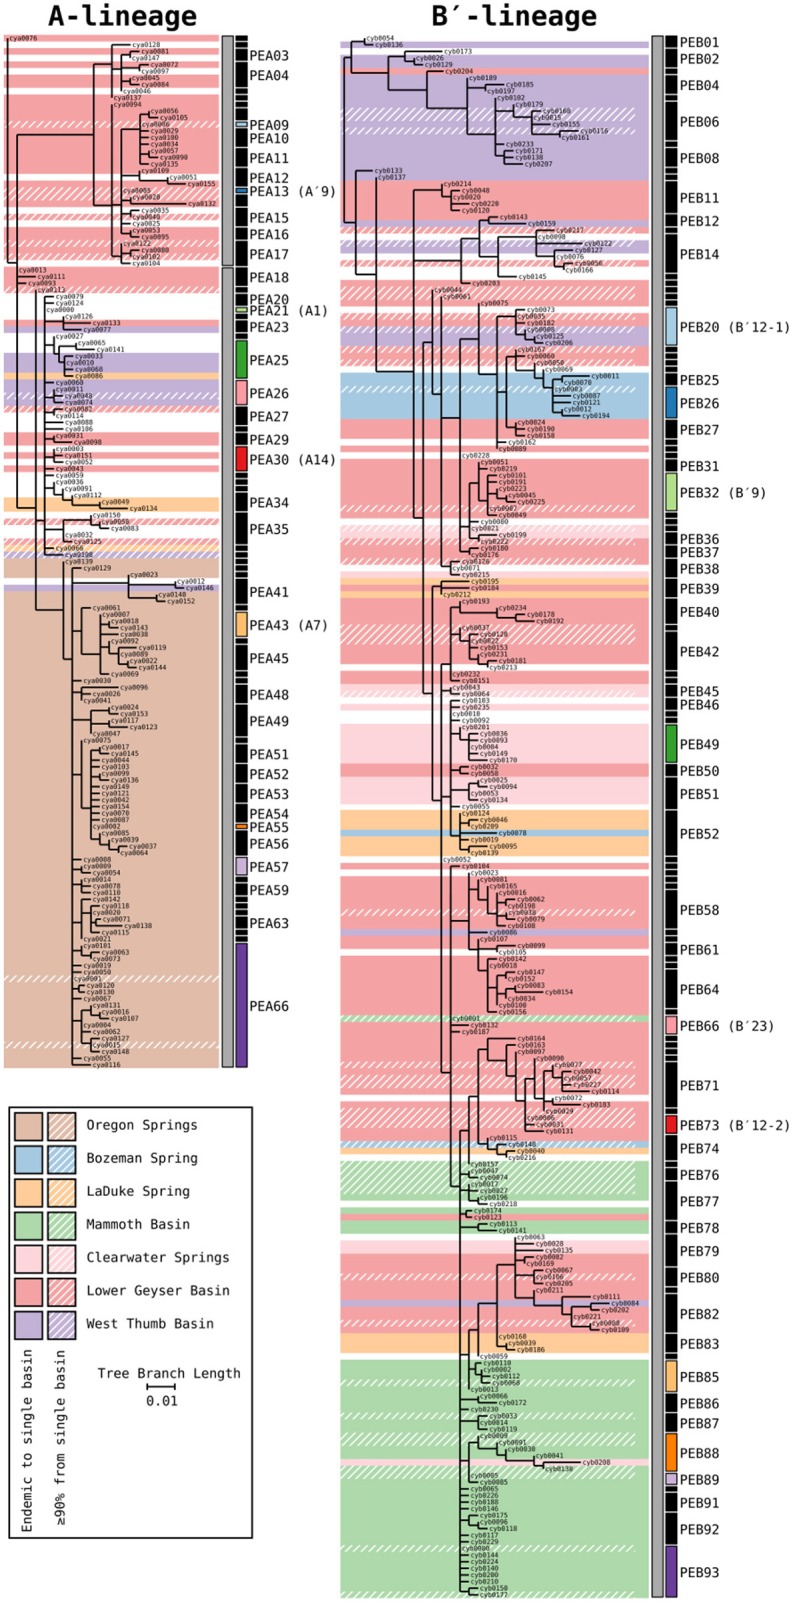
Phylogenies of 16S rRNA defined A′ (PEA1-PEA17), A (PEA18-PEA66), and B′-like Synechococcus (gray bars) based on partial psaA gene HFS10 variants from Yellowstone National Park, Montana, and Oregon Springs, with putative ecotype (PE) demarcations based on Ecotype Simulation 2 (ES2). Shaded regions of the trees mark branches that are endemic to a single basin. Regions with a diagonal hatch mark branches predominantly found in a single basin (>90%). The ES2 PE demarcations are displayed next to each tree as vertical black and colored bars, with colored bars representing predominant PEs analyzed in detail. Demarcation colors are reused between the A- and B′-like phylogenies and are the same in later figures. Labels are skipped for most PEs with only a single member.